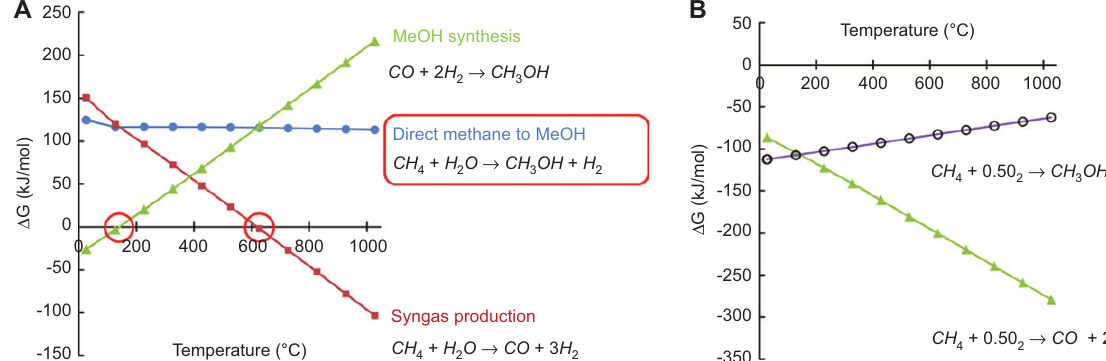
Figure 1 Methane conversion routes. (A) The Gibbs free energy for R1~R3 and (B) R4.